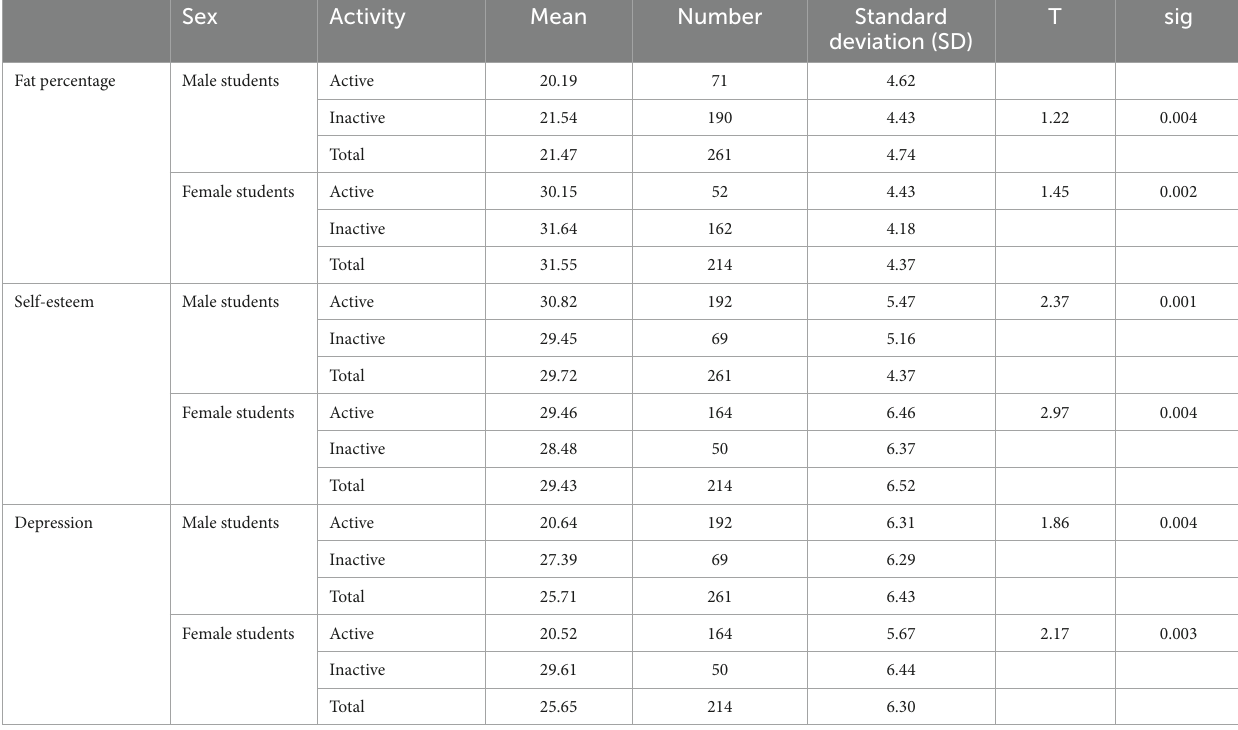
TABLE 1 Comparison of body fat percentage, self-esteem, and depression of male and female students based on their activity level. Sex